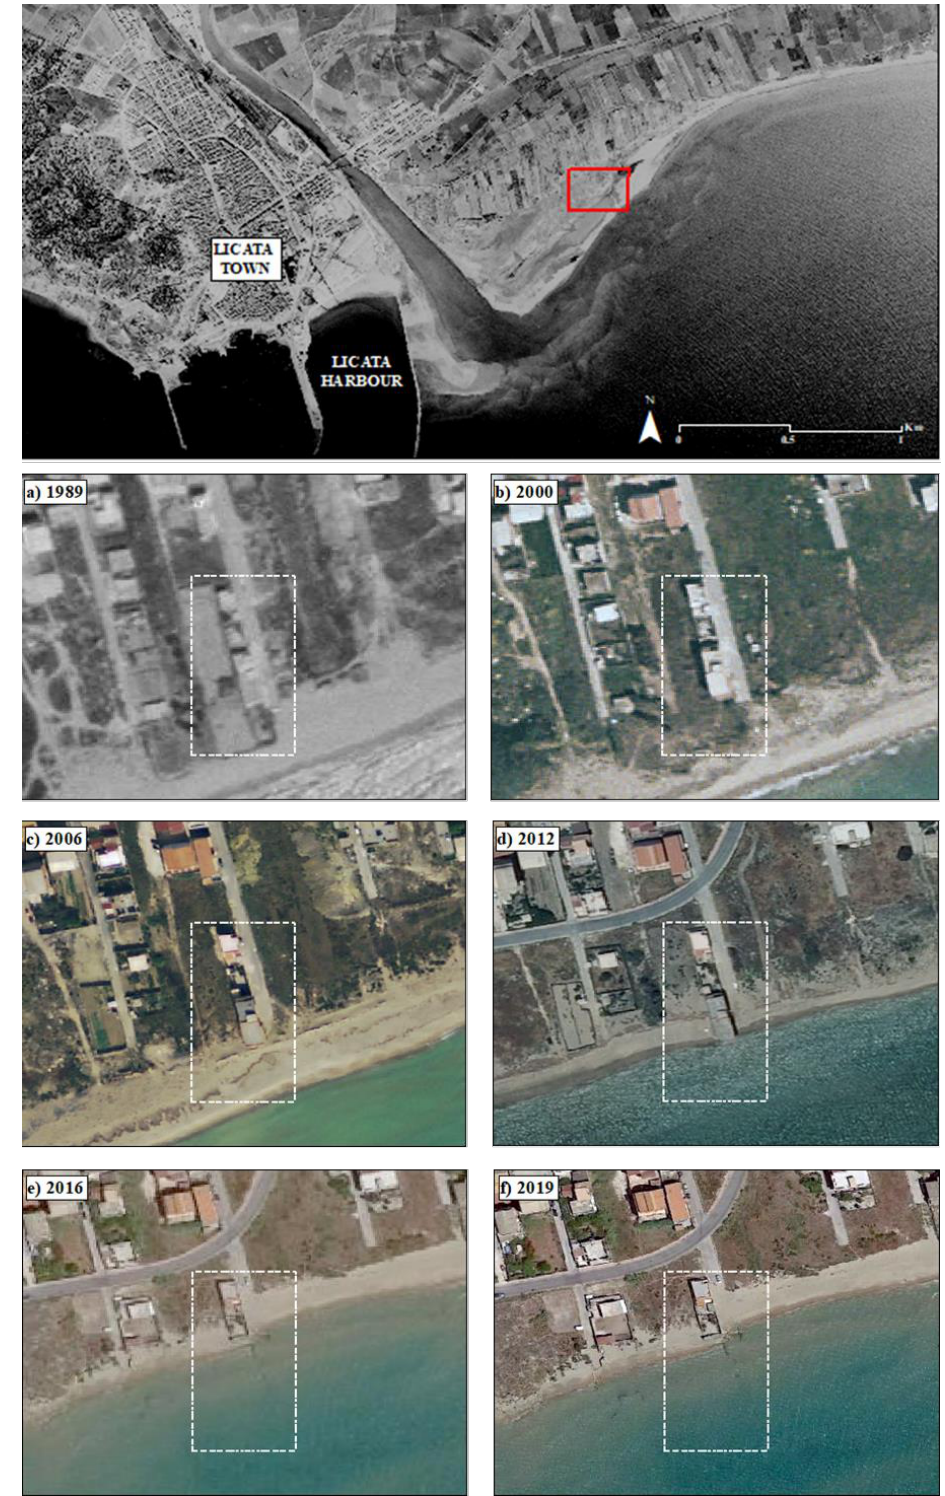
Figure 4. The area east of the Southern Imera River mouth faced severe coastal erosion. In 1955, the coastal area was undisturbed, but over the following decades, urbanization and anthropogenic disturbance have significantly increased, despite the severe erosion observed within this area, and ( a – f ) holidays houses have been seriously damaged and partly submerged, as shown by the white square that frames a house partly swallowed up by the sea.